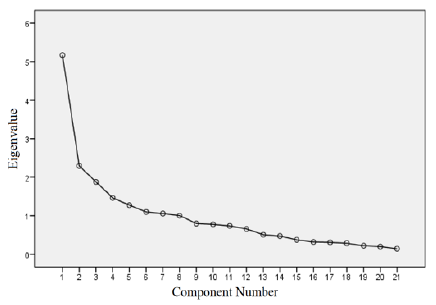
Figure 01: Scree plot for Dimension